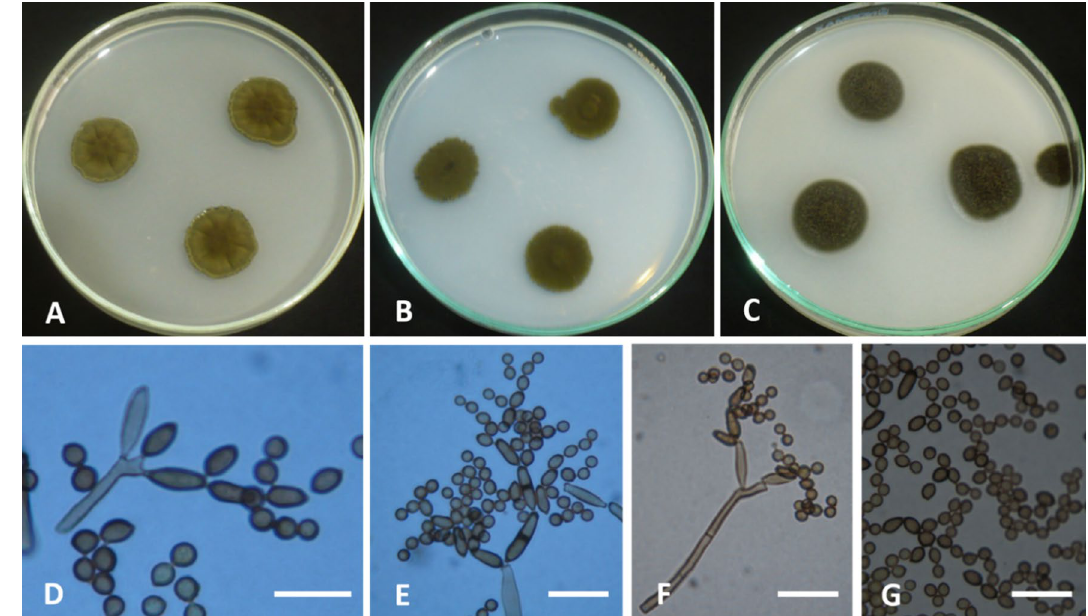
Figure 4. Cladosporium parasphaerospermum (AUMC 10865). ( A–C ) 7-day-old colonies on PDA, SNA and OA at 25 °C. ( D–F ) Macronematous conidiophores and conidial chains. ( G ) Globose to subglobose conidia. Scale bar = 20 µm ( D ), 10 µm ( E–G ).